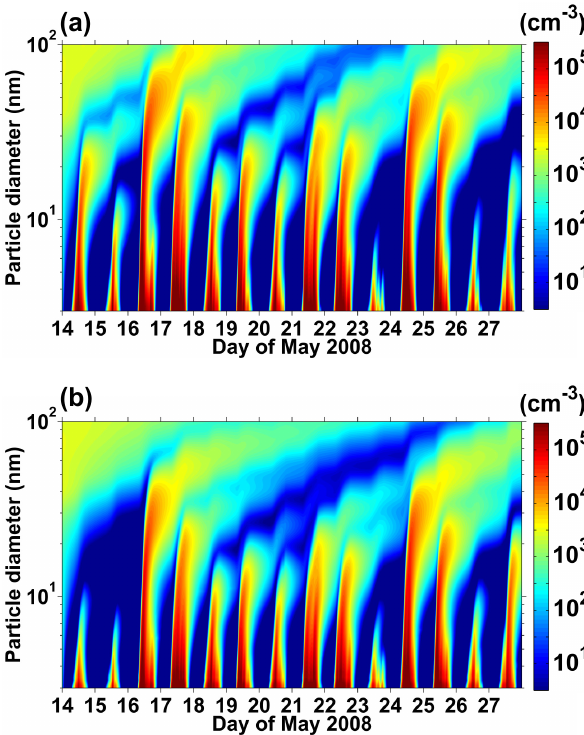
Fig. 12. Simulated particle number size distribution [cm − 3 ], ex- pressed as d N /dLog D p showing model sensitivity on (a) sulfuric acid concentrations which have been enhanced by a factor 3.2 in order to match the observed values and (b) on the mass accom- modation coefficient, set to 0.43 for each condensable compound (P¨oschl et al., 1998). Model simulations have been performed set- ting 250 sections in order to match the size resolution of the SMPS and initialized with the PSD observed on 14 May at 00:00